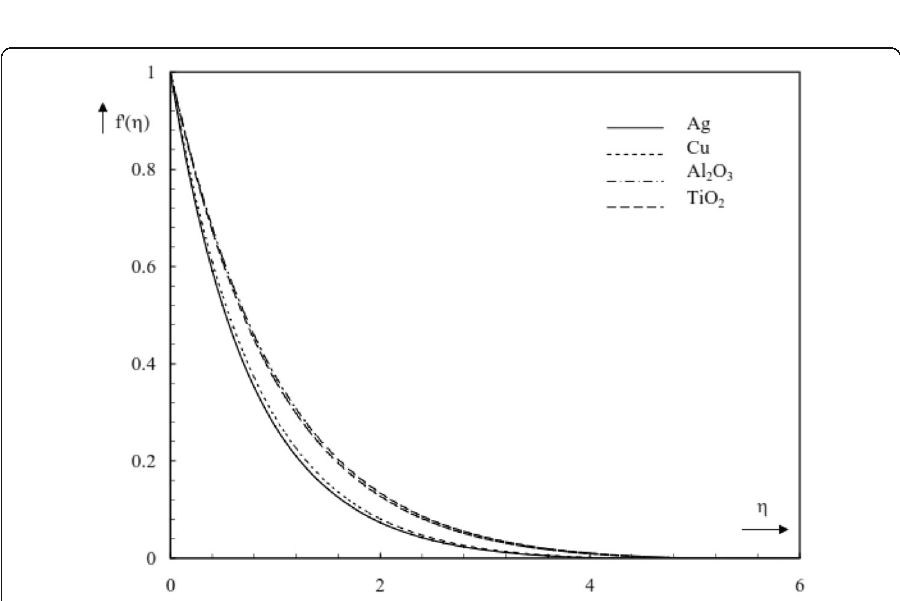
Fig. 3 Velocity profile for different types of nanofluids for S = M = f w = 0.1 and A = B = λ =